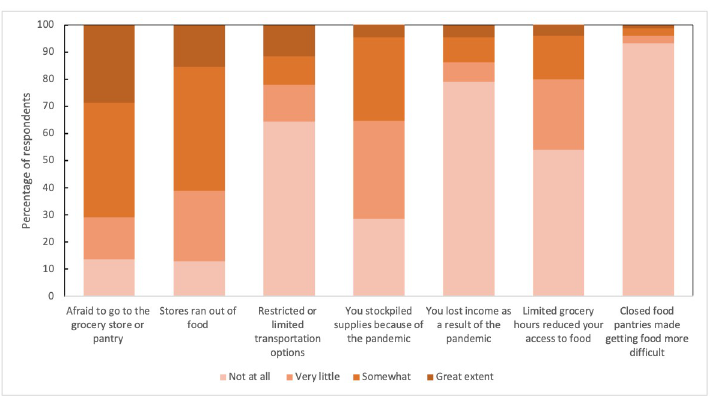
Fig 1. Descriptive statistics for pandemic-related variables used in the